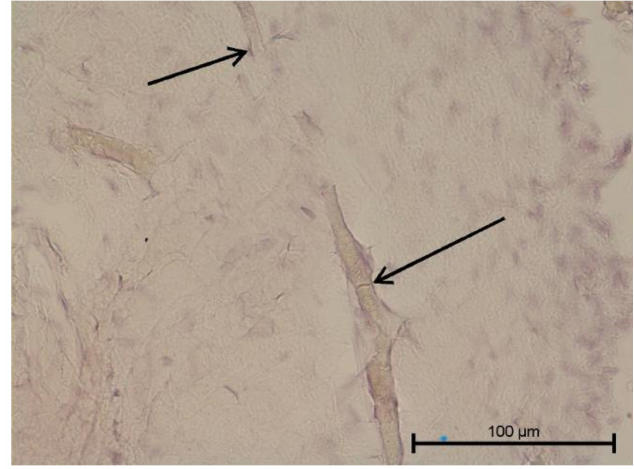
Figure 13. Light microscope image. Healthy tooth. Collagen IV—positive (black arrow). Mag. 400 × .